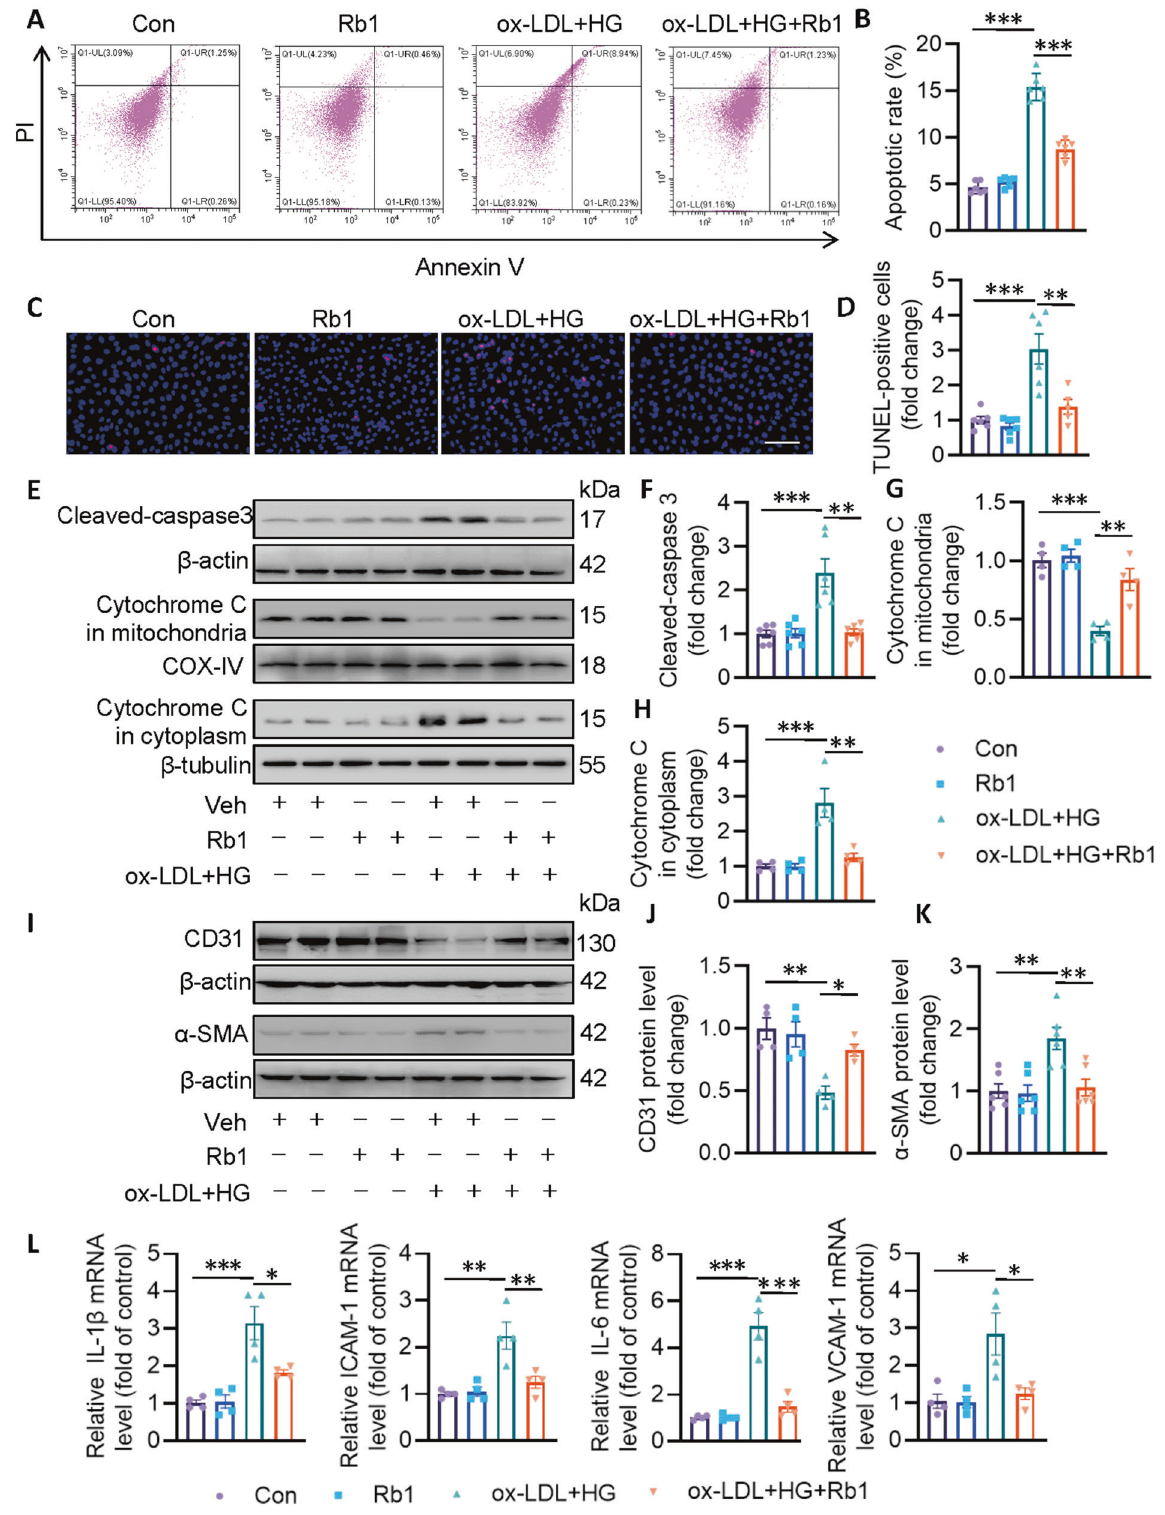
Fig. 2 Rb1 protects ECs from ox-LDL/HG-induced cell apoptosis, EndMT, and in fl ammation. EA.hy926 ECs were pretreated with Rb1 (10 μ M) for 30 min before ox-LDL/HG for 24 h. A Cell apoptosis measured by fl ow cytometer. B Apoptosis ratio. C Cell apoptosis measured by TUNEL assay. Scale bar = 200 μ m. D Relative analysis of TUNEL-positive cells. E – H Representative blots and quantitative analysis of cleaved-caspase3, mitochondrial cytochrome c, cytoplasmic cytochrome c. I – K Representative blots and quantitative analysis of CD31 and α -SMA. L Relative mRNA levels of IL-1 β , ICAM-1 , IL-6 , and VCAM-1 . Data are presented as mean ± SEM. n = 4 – 6. Statistical analysis was performed with the randomized block ANOVA. * P < 0.05; ** P < 0.01; *** P < 0.001; vs . indicated group.